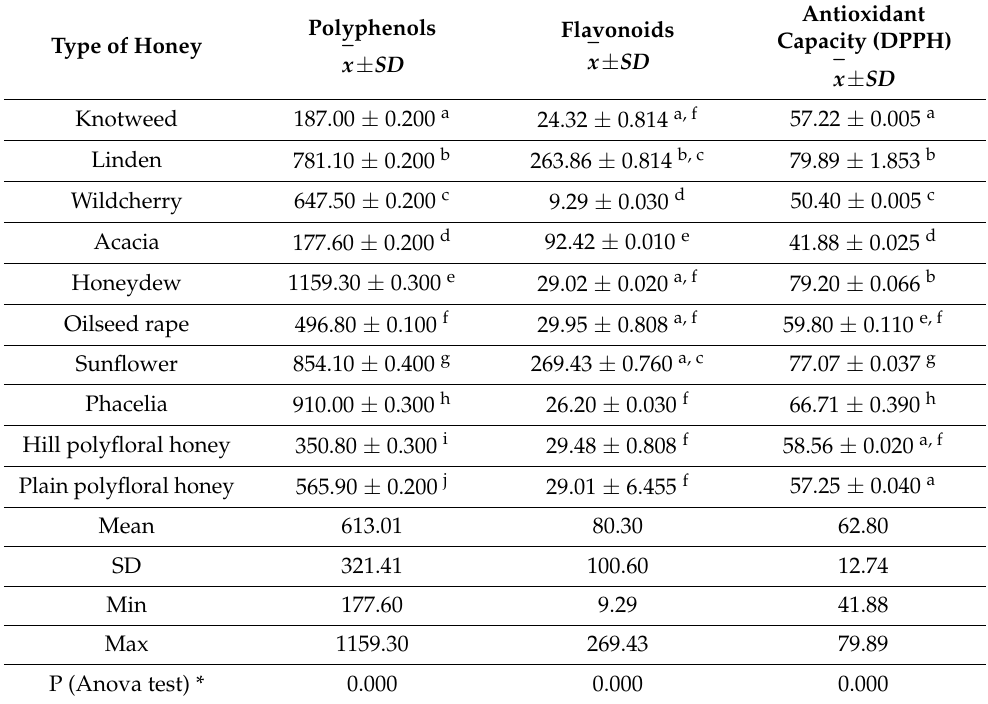
Table 2. The content of polyphenols, flavonoids and the antioxidant capacity of the honey from the region of Banat, Romania. Antioxidant Polyphenols Flavonoids Capacity (DPPH) Type of Honey ¯ ¯ x ± SD ¯ x ± SD x ± SD Knotweed 187.00 ± 0.200 a 24.32 ± 0.814 a, f 57.22 ± 0.005 a Linden 781.10 ± 0.200 b 263.86 ± 0.814 b, c 647.50 ± 0.200